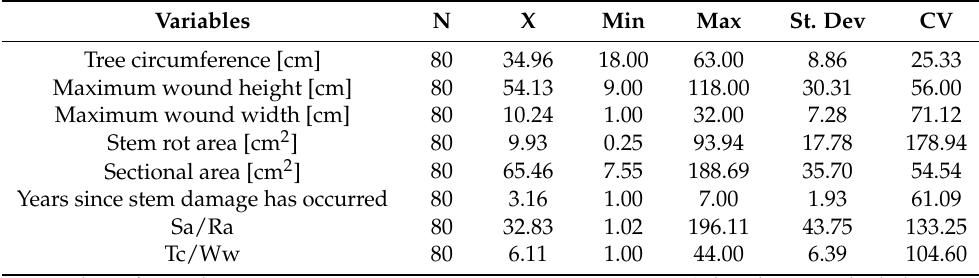
Table 1. Statistical values of the studied characteristics.